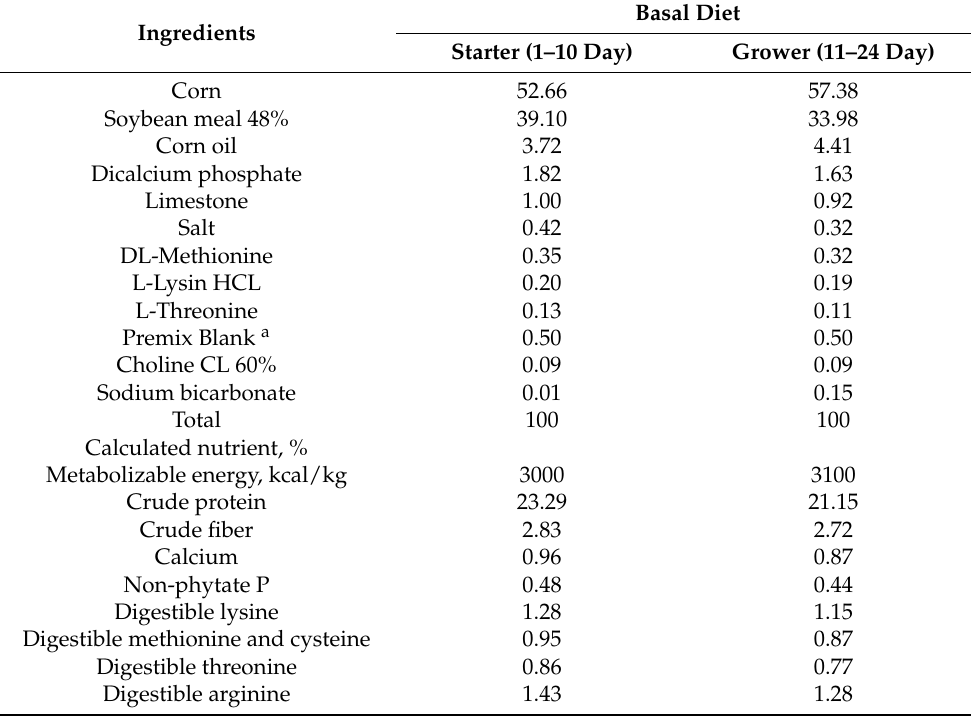
Table 1. Feed ingredients and nutrient content of the basal diets